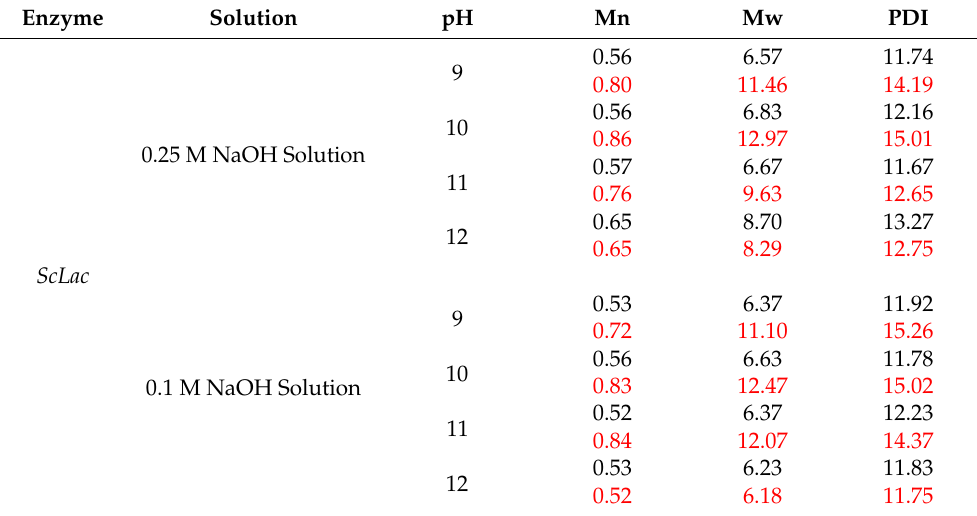
Table 3. Mn, Mw, and PDI values (in KDa) of untreated (black) and ScLac -treated (red) APL at different pH (9, 10, 11, and 12) in 0.25 M and 0.1 M NaOH solutions.